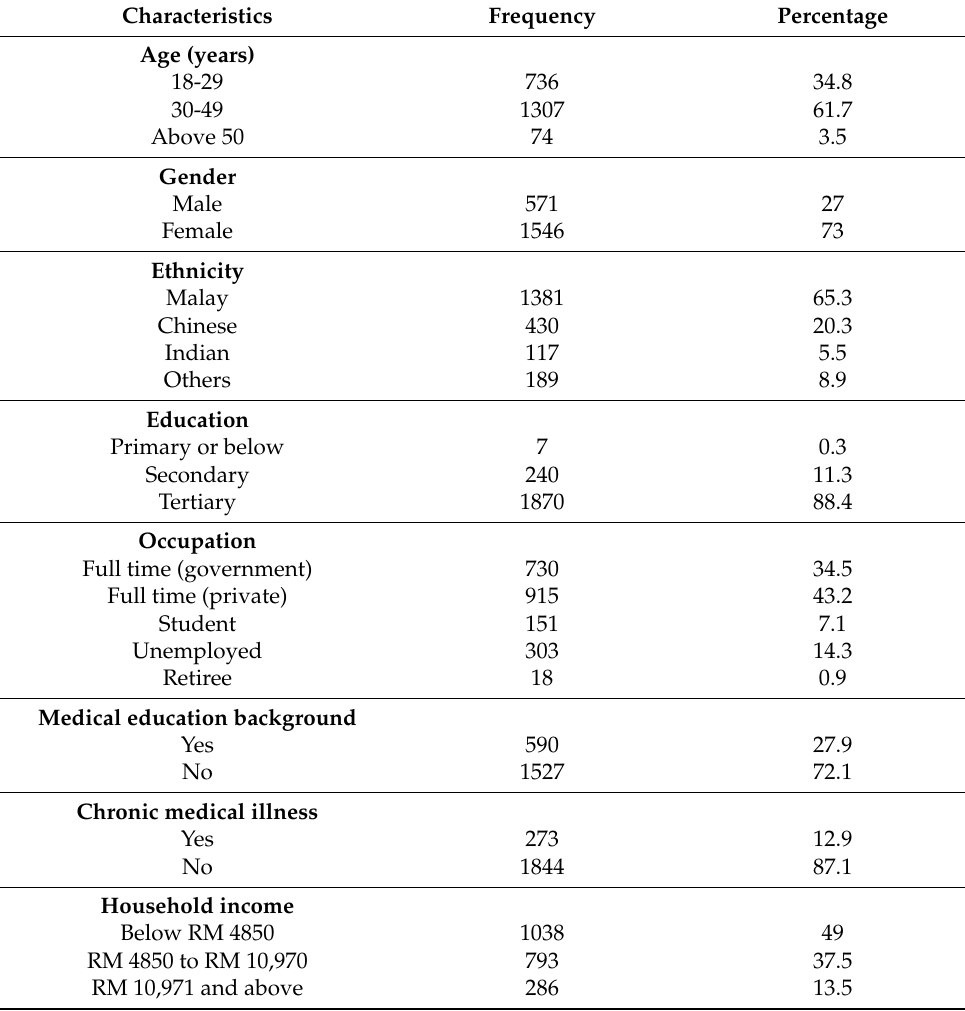
Table 1. Demographic characteristics ( n =